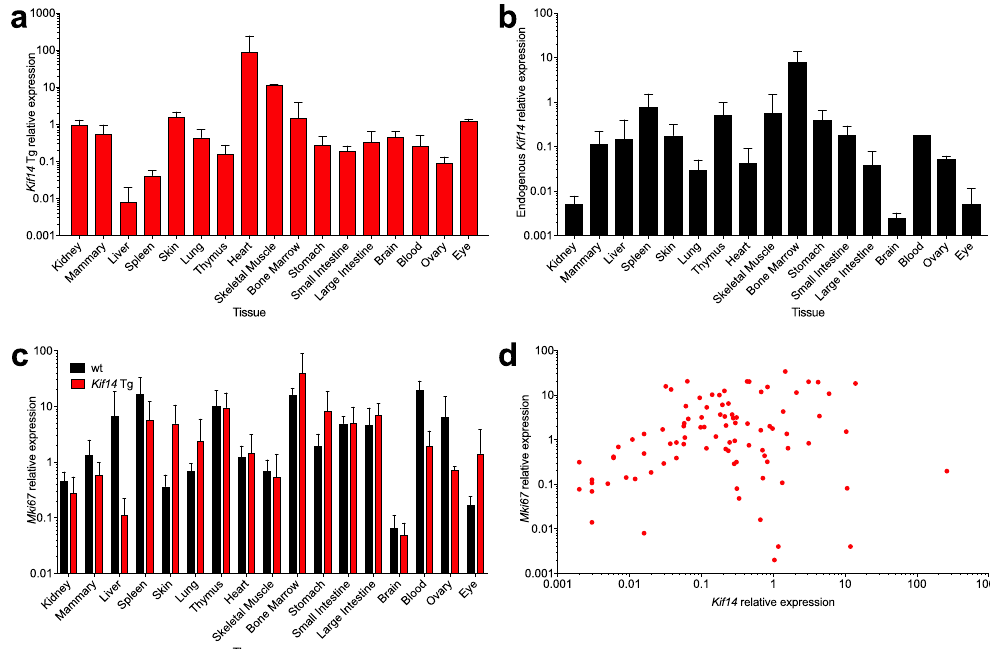
Figure 1. Kif14 gene expression and proliferation in Kif14 transgenic (Tg) and wild-type (wt) mice. ( a ) The Kif14 transgene is expressed in all tissues analyzed in Tg mice. ( b ) Endogenous Kif14 is expressed in all tissues analyzed in wt mice. ( c ) Mki67 proliferation marker is increased in some Kif14 Tg tissues compared with wt tissues. ( d ) Mki67 expression positively correlates with Kif14 expression (Spearman’s ρ = 0.21, p = 0.04). All individual samples from all tissue types analyzed are shown (both wt and Tg mice, endogenous Kif14 and Kif14 Tg, respectively). qRT-PCR for the indicated genes, normalized to Hprt and Tbp and reported relative to a pool of all tissues. Mean ± s.d. of results from 3 individual mice shown. Note differences in y-axis scales between